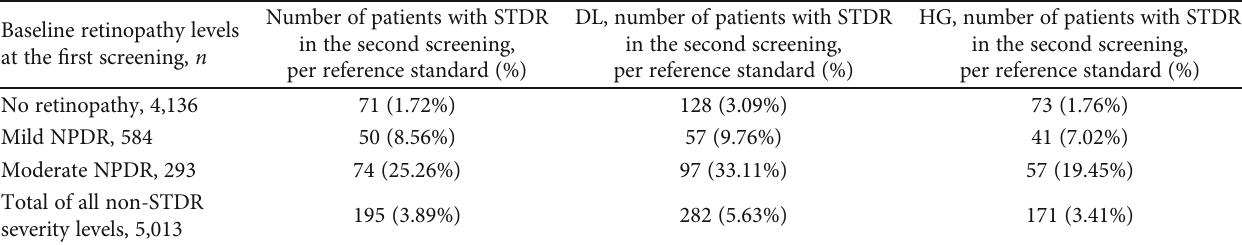
STDR: sight-threatening diabetic retinopathy; NPDR: nonproliferative diabetic retinopathy; DL: deep learning; HG: trained human graders. p < 0 : 001 for the proportions of STDR of patients in the di ff erent baseline severity levels from the fi rst screening in each